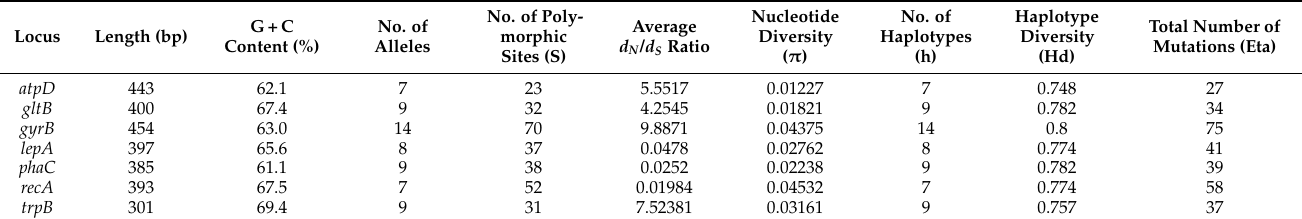
The average G+C content of the MLST loci ranged from 61.1% for phaC to 69.4% for trpB . The number of polymorphic nucleotide sites (S) varied from 23 ( atpD ) to 70 ( gyrB ), in which the gyrB allele possessed the most polymorphic sites at the nucleotide level. The nucleotide diversity indices ( π ) of the seven loci ranged from 0.01227 ( atpD ) to 0.04532 ( recA ). The haplotype diversity (Hd) ranged from 0.748 for atpD to 0.8 for gyrB . The nonsynonymous to synonymous ( d N /d S ) ratio measures the level and mode of natural selection acting on protein-coding genes. A d N /d S ratio of <1 indicates negative selection (purifying selection), in which nonsynonymous sites evolved more slowly than synonymous sites during the evolutionary process; a d N /d S >1 indicates positive selection (adaptive selection); and neutral selection is indicated if values are close to 1. The d N /d S ratios for the seven loci varied from 0.01984 ( recA ) to 9.8871 (gyrB ). The d N /d S ratios were extremely high ( d N /d S > 1) in four genes ( atpD , gltB , gyrB , and trpB ), indicating positive selection in the four housekeeping proteins. The d N /d S of recA , phaC , and lepA genes was <1, indicating a purifying selection during the evolutionary